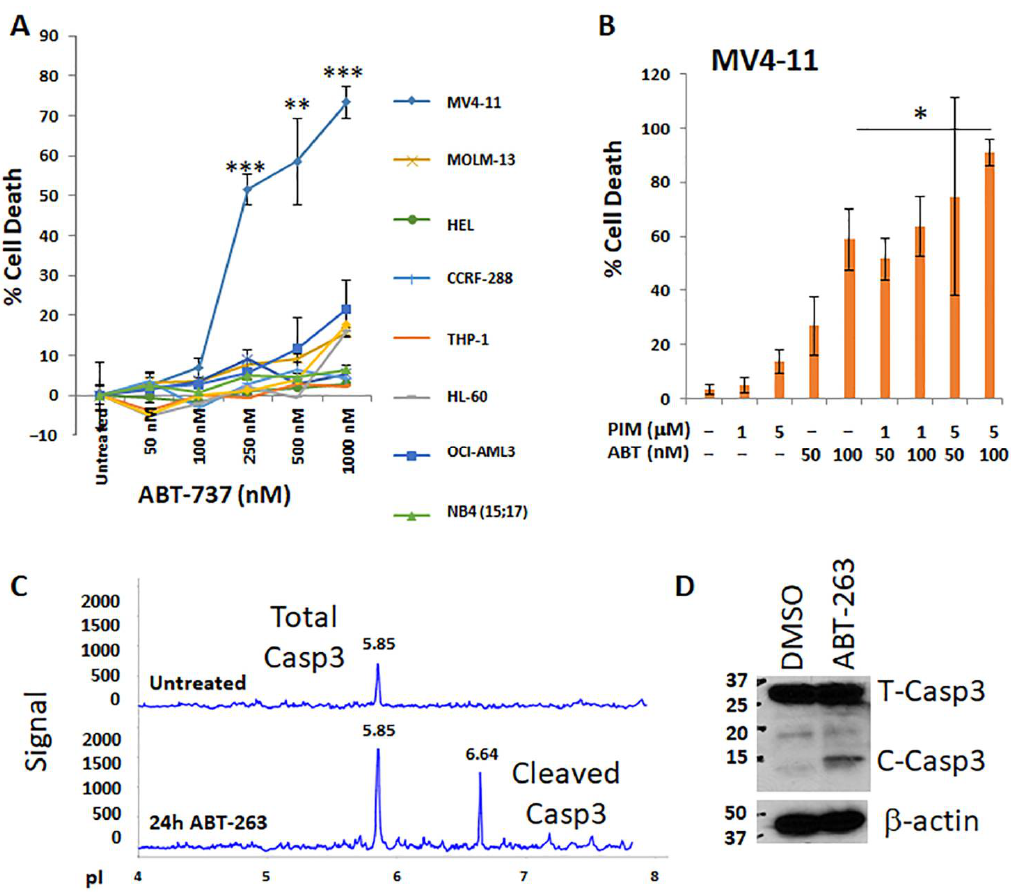
Figure 1. Most human AML cell lines are highly resistant to BH3 mimetic treatment except homozygous Flt3-ITD+ MV4-11 cells. ( A ) A panel of AML cell lines representing various cytogenetic and mutation status was treated by the BH3 mimetic ABT-737. The trypan blue exclusion assay was performed 48 h post-treatment. Cell death was normalized to untreated cells and in some instances survival was greater than control leading to slightly negative y -axis values. ( n = 3; p values were calculated relative to the untreated control). * p < 0.05; ** p < 0.01; *** p < 0.001. ( B ) MV4-11 cells were treated for 48 h